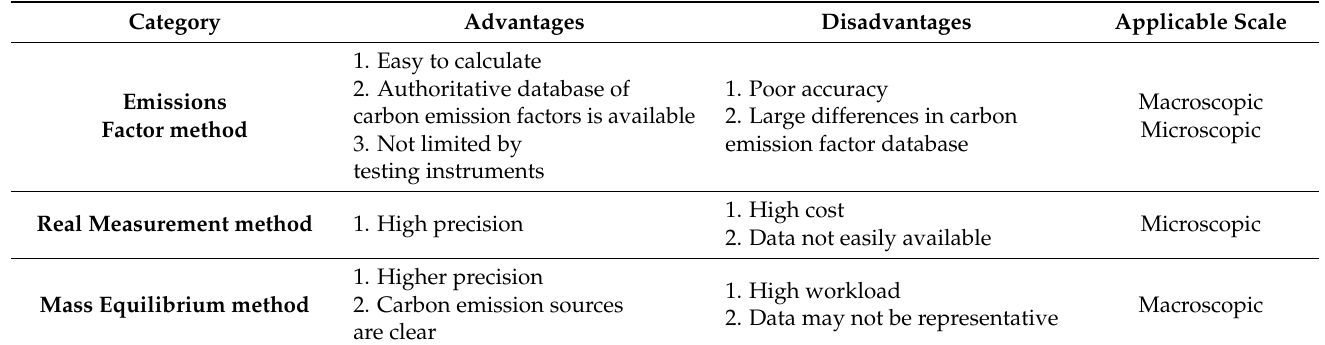
Table 1. Comparison of carbon emission measurement methods [13–15]. Advantages Disadvantages Applicable